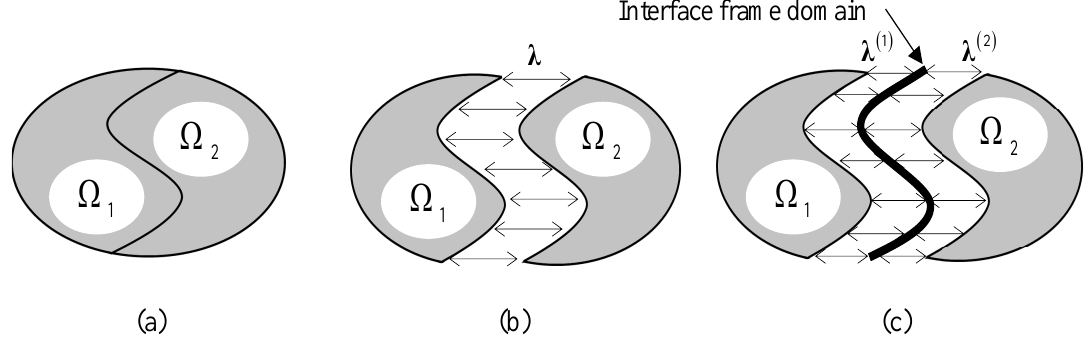
Figure 3. Simple patch test problem: ( a ) a continuum structure composed of two subdomains, and each subdomain is connected using the ( b ) classical and ( c ) localized version.